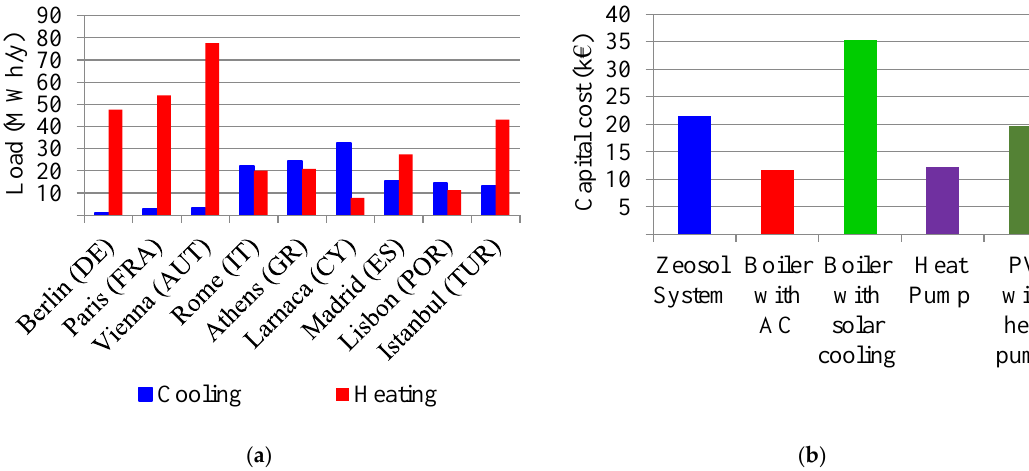
Figure 13. ( a ) Cooling / heating loads for the considered building in the investigated regions and ( b ) capital costs for the considered systems.